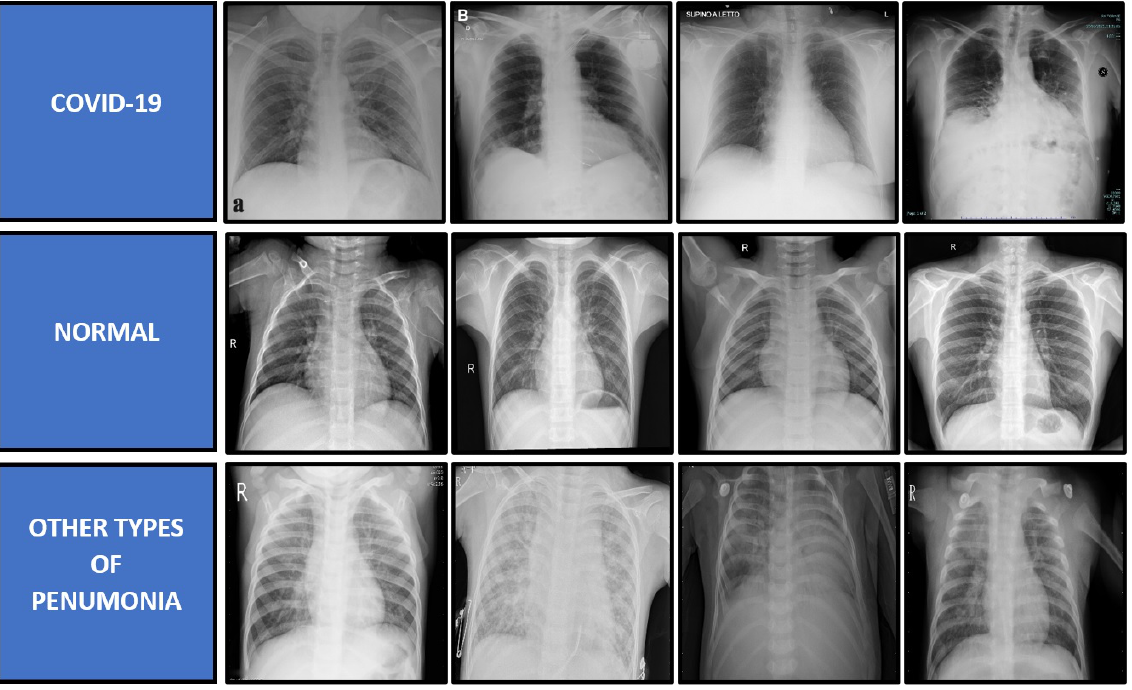
Figure 4. Samples of X-ray images for each category of COVID-19, normal and other types of pneumonia